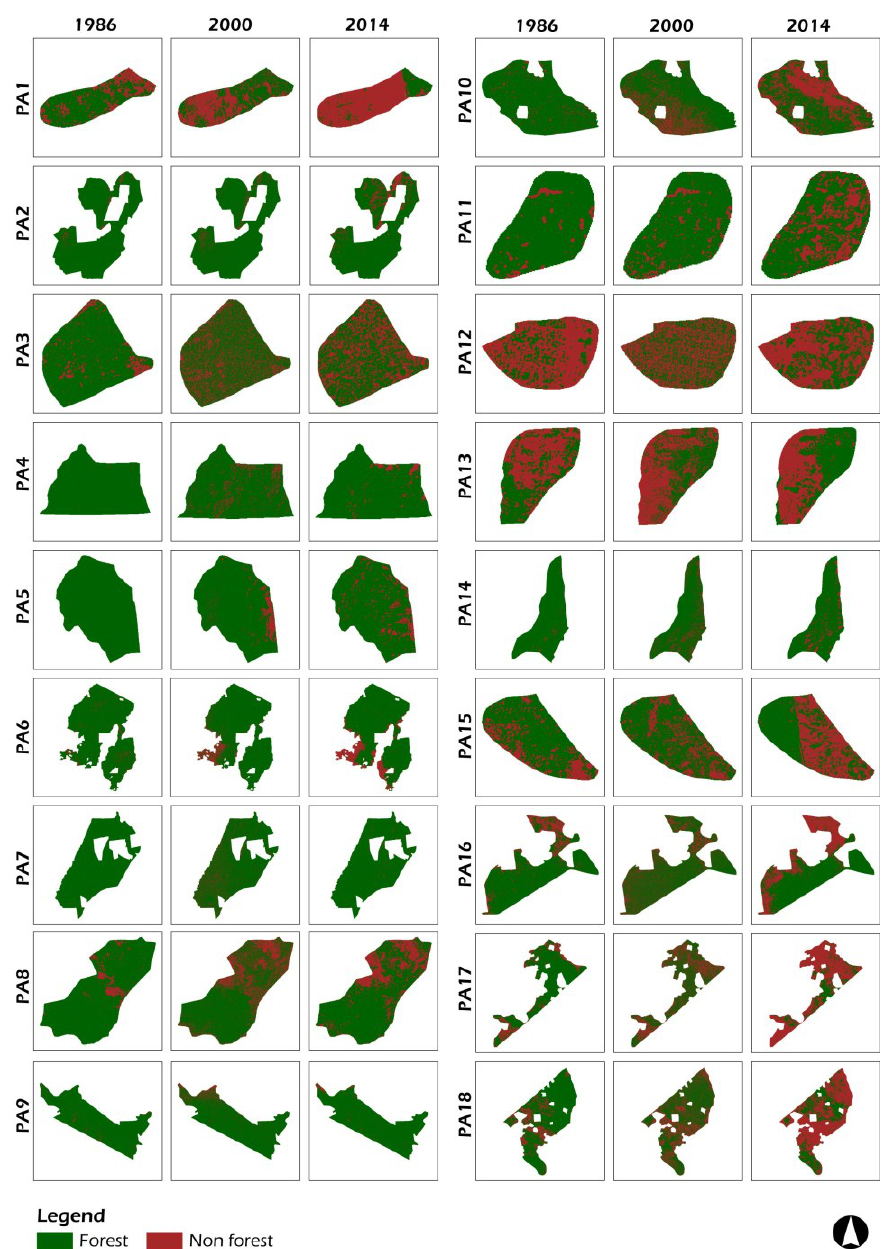
Figure 3. Forest and non-forest maps of protected areas in Cross River for 1986, 2000 and